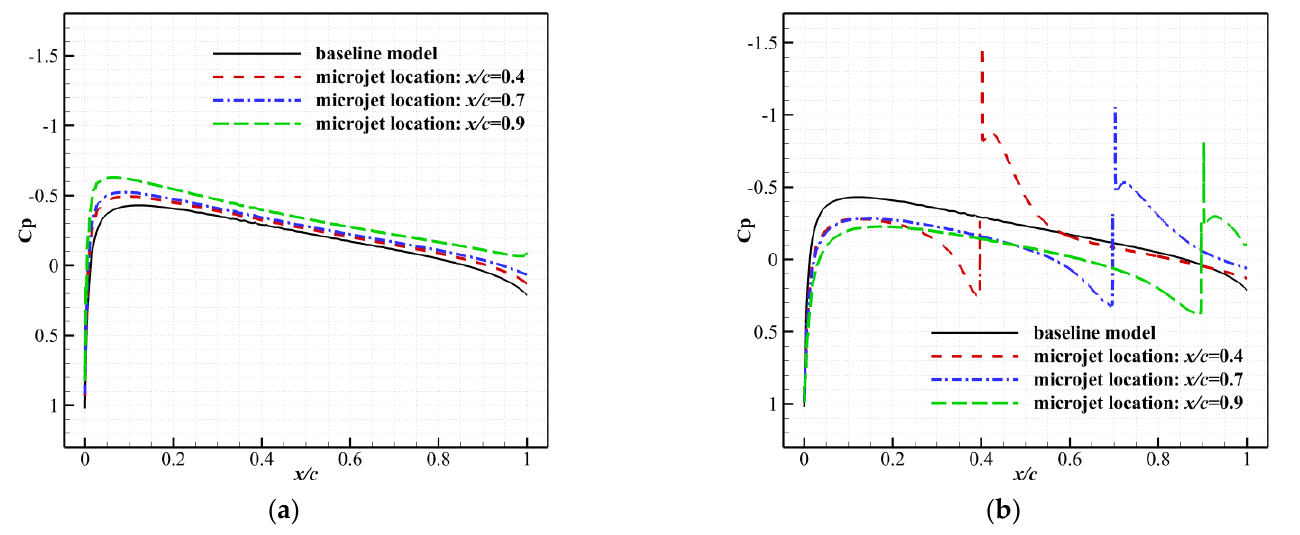
Figure 4. Comparisons of pressure coefficients between the baseline model and microjet blowing models at M ∞ = 0.3, α = 0° (from [30]). ( a ) Lower surface; ( b ) Upper surface.